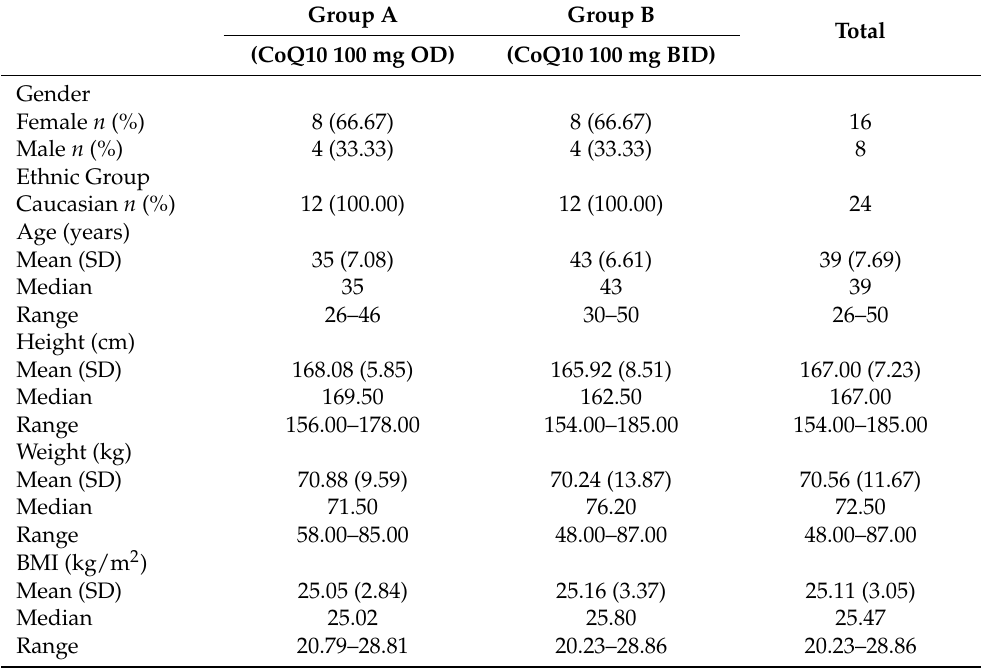
Table 1. Demographic features of subjects randomized in each CoQ10 treatment group.